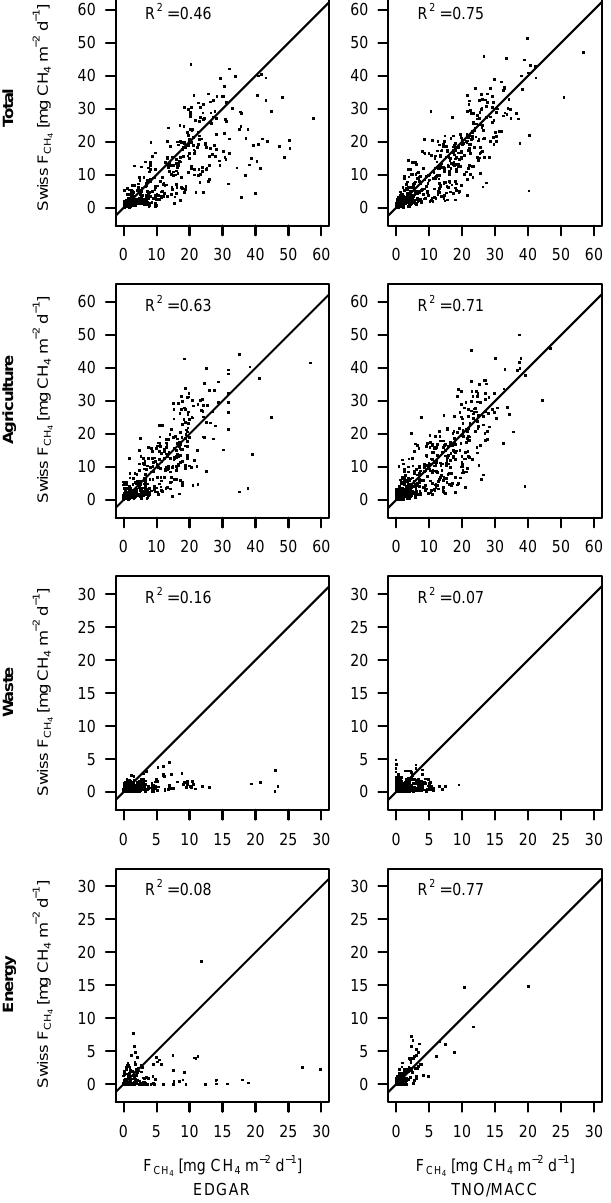
Fig. 4. Scatterplot between all pixel values in the EDGAR v42 and TNO/MACC inventories in Switzerland versus our inventory re- duced to the respective resolution of the coarser inventory. Plots are shown for total emissions as well as for the sectors agricultural (EDGAR: IPCC_4A, IPCC4B and TNO/MACC: SNAP code 10), waste (EDGAR: IPCC_6A_6C, IPCC_6B and TNO/MACC: SNAP code 9) and energy (EDGAR: IPCC_1B2b and TNO/MACC: SNAP code 5) separately. The solid lines indicate the 1:1 relationship. The panels were scaled to show as much detail as possible and hence a few very large emissions were omitted.